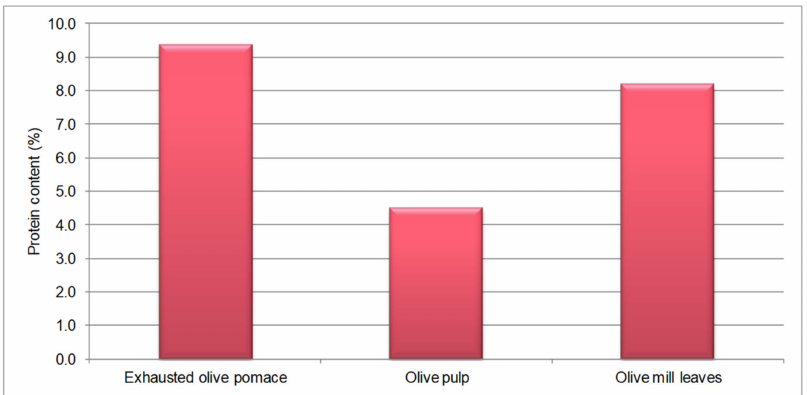
Figure 1. Crude protein content in olive-derived biomasses, adapted from Contreras et al. [3].